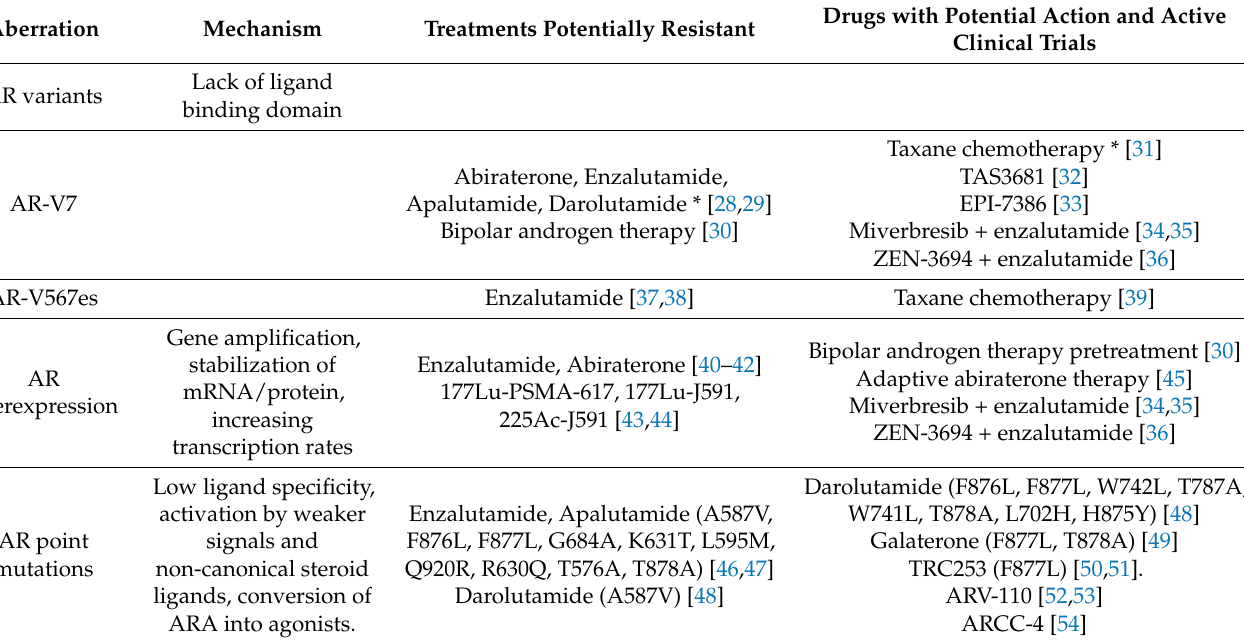
Table 2. AR-mediated androgen receptor signaling inhibitor resistance mechanisms and drugs with potential